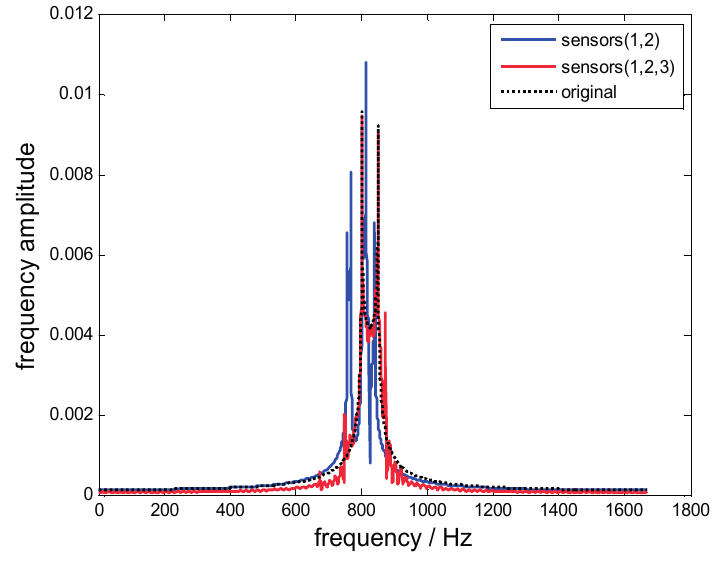
Figure 12. Frequency spectra of reconstructed signals with 800 . Hz